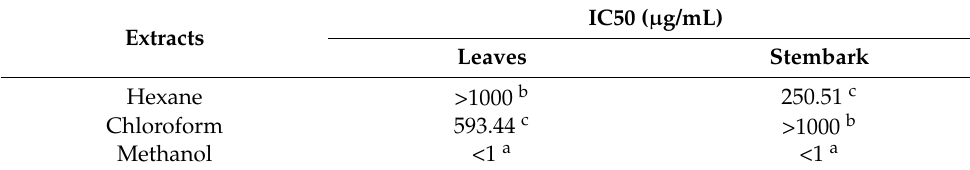
Table 2. FRAP free radical reducing activities (IC50 values) of the leaf and stembark extracts (hexane, chloroform, and methanol) of C. erythrophyllum (a–c indicate significantly different data. Tukey’s honest significant difference multiple range post hoc test p < 0.05 IBM SPSS version 27).